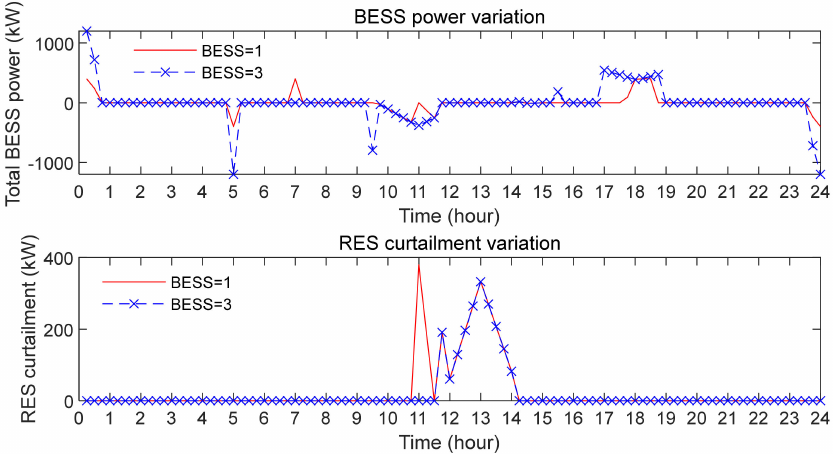
Figure 9. Variations of BESS power and RES curtailment for load type B (the distribution operator cannot sell electricity to the utility grid).